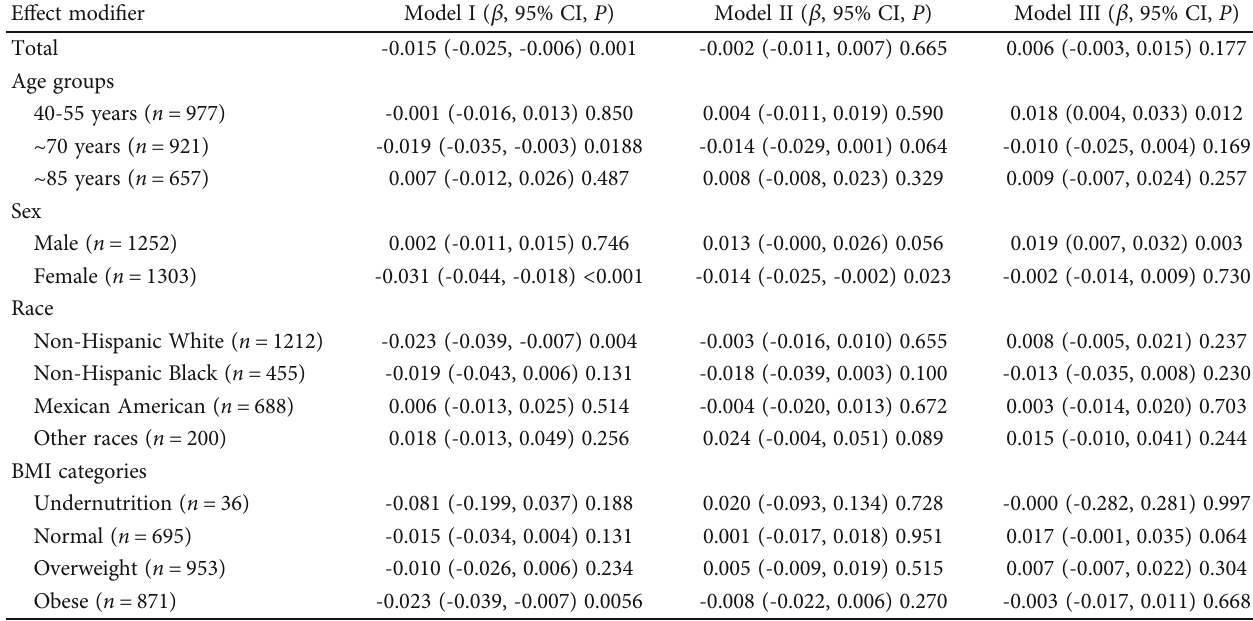
Table 2: Association of H. pylori seropositive and total bone mineral